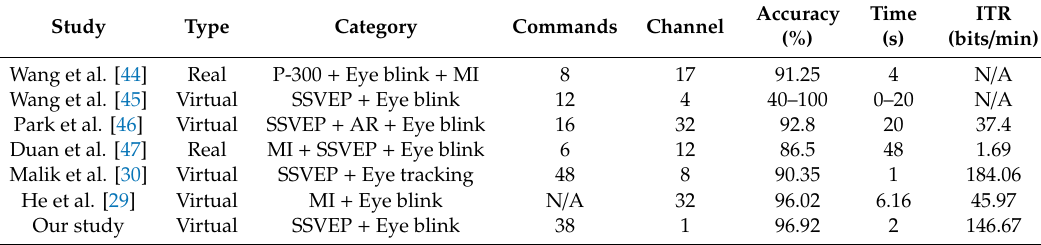
Table 3. Related works regarding the hybrid EEG and eye blink BCI